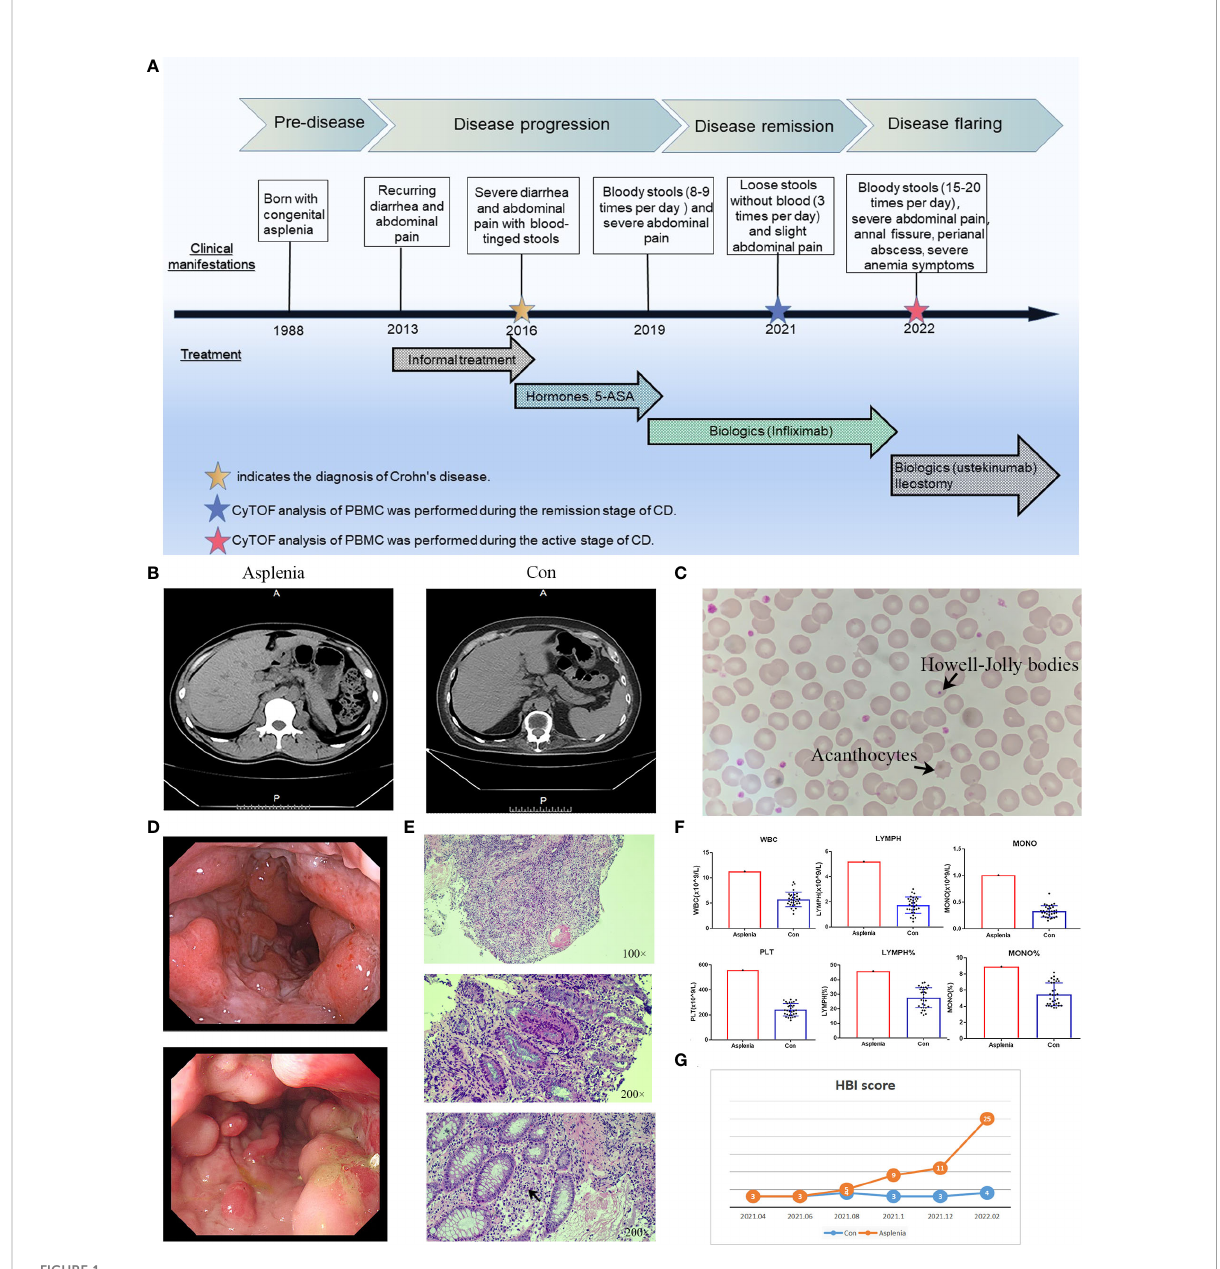
FIGURE 1 Clinical characteristics in the patient with both ICA and CD. (A) Timeline of the clinical events and treatment strategies. (B) Abdominal CT images of the congenitally asplenic patient (left) and the control (right). (C) Morphological examination of peripheral blood smear of the congenitally asplenic patient showed the acanthocytes and Howell-Jolly bodies within red blood cells (arrows). (D) Colonoscopy demonstrating multiple longitudinal deep ulcers with mucosal oedema and cobblestone appearance in the hepatic fl exure (top panel) and the sigmoid colon (bottom panel) of the asplenic CD patient. (E) Hematoxylin-eosin staining of the colonoscopic biopsy tissue from the asplenic CD patient showing the in fi ltration of lymphocytes, plasma cells and neutrophils in the lamina propria of the mucosa, discontinuous severe crypt distortion (top panel) as well as the ulcer (middle panel) and crypt abscess (bottom panel, arrow) formation. (F) The histograms demonstrating the elevated WBC (white blood cell count), PLT (platelet count), LYMPH (absolute number of lymphocytes), LYMPH% (percentage of lymphocytes), MONO (absolute number of monocytes) and MONO% (percentage of monocytes) of the asplenic CD patient in remission compared to remission controls (n=32) with normal spleens randomly selected from our center ’ s CD cohort. (G) Line graph showing the difference in disease progression between the asplenic patient and the control after the fi rst CyTOF analysis (HBI score used to evaluate disease activity of